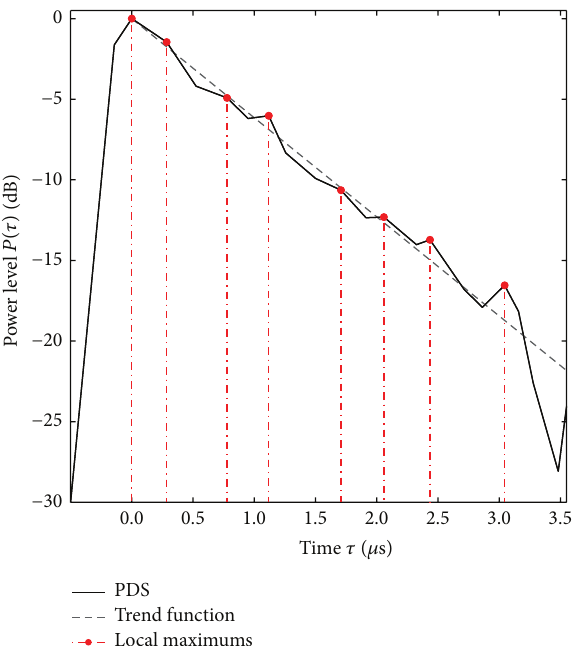
Figure 2: Identification of parameters for individual clusters on the example of measurement scenario from [1]